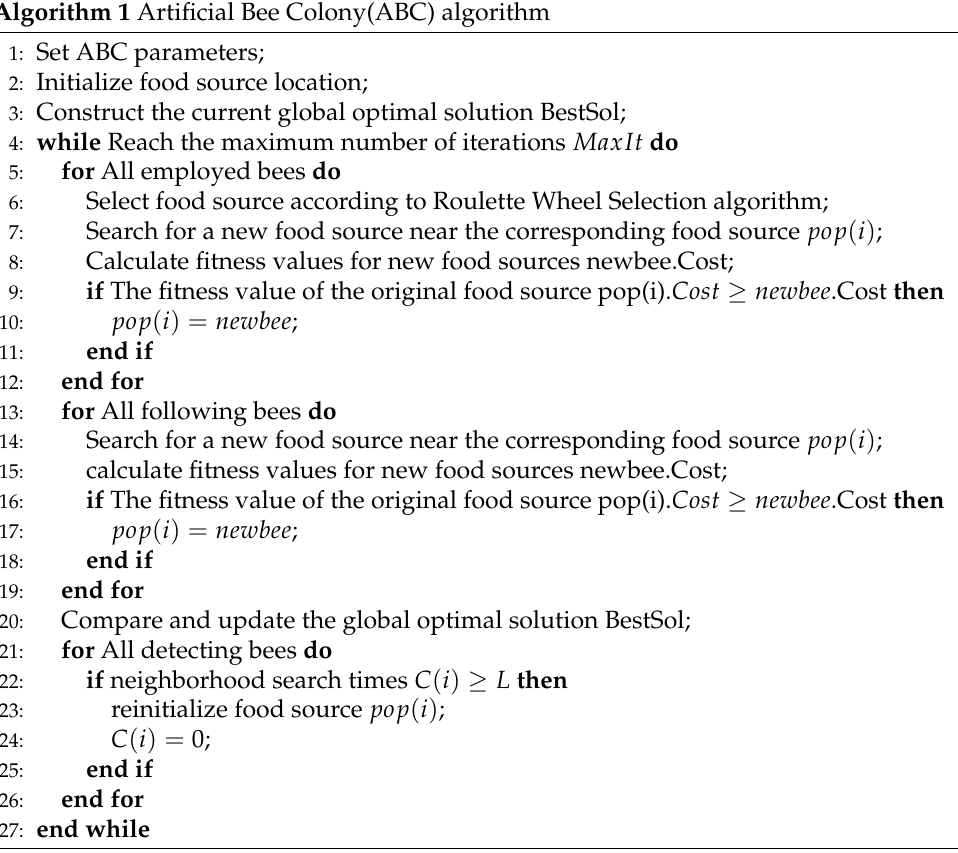
Algorithm 1 Artificial Bee Colony(ABC)